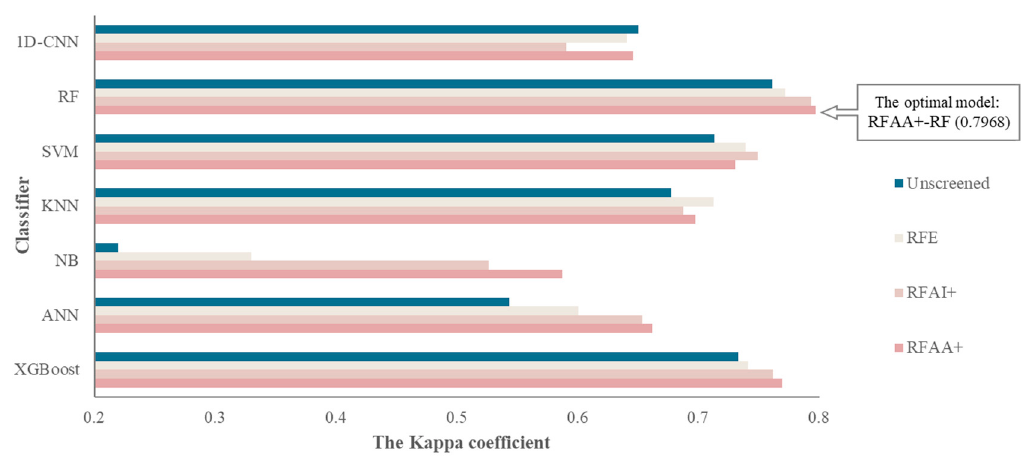
Figure 6. The kappa coefficients of coupling models for multiple crop classification. RF = random forest; SVM = support vector machine; KNN = K-nearest neighbor classification; NB = naïve bayes; ANN = artificial neural network; XGBoost = Extreme Gradient Boost; 1D-CNN = one-dimensional convolutional neural network; RFAA+ = improved average accuracy reduction; RFAI+ = improved random forest average impurity; RFE = recursive feature elimination.